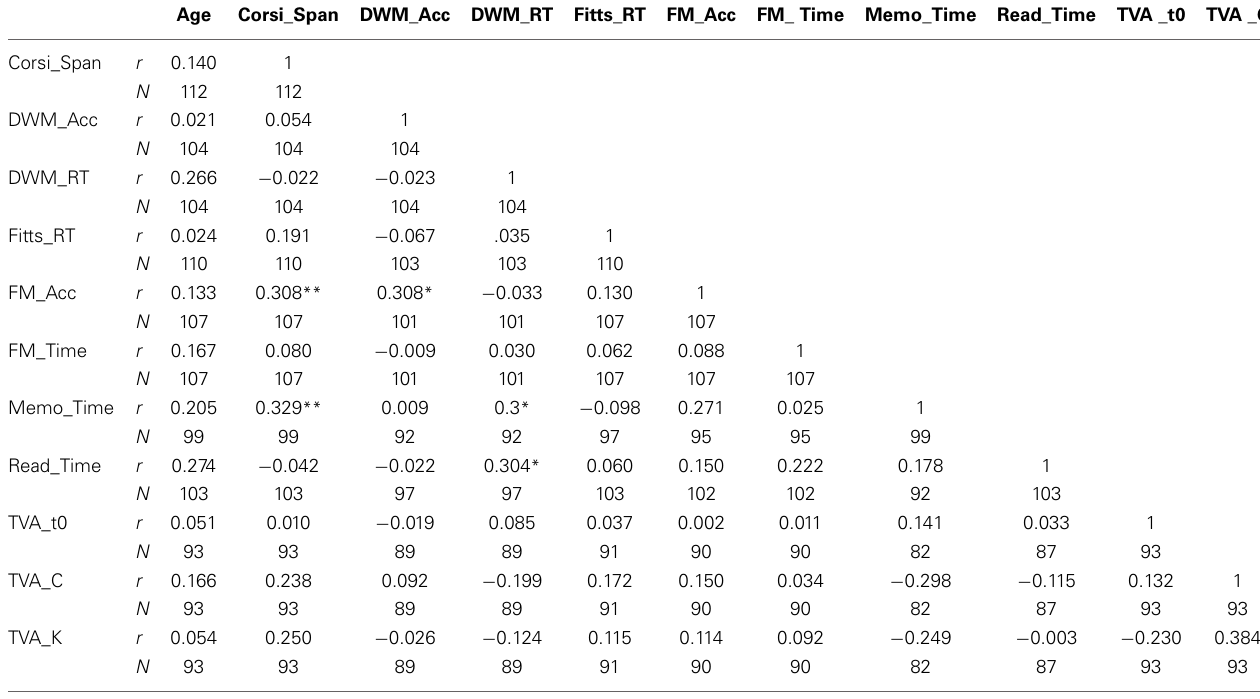
Table 3 | Correlation analysis (Pearson’s r ) of the dataset.